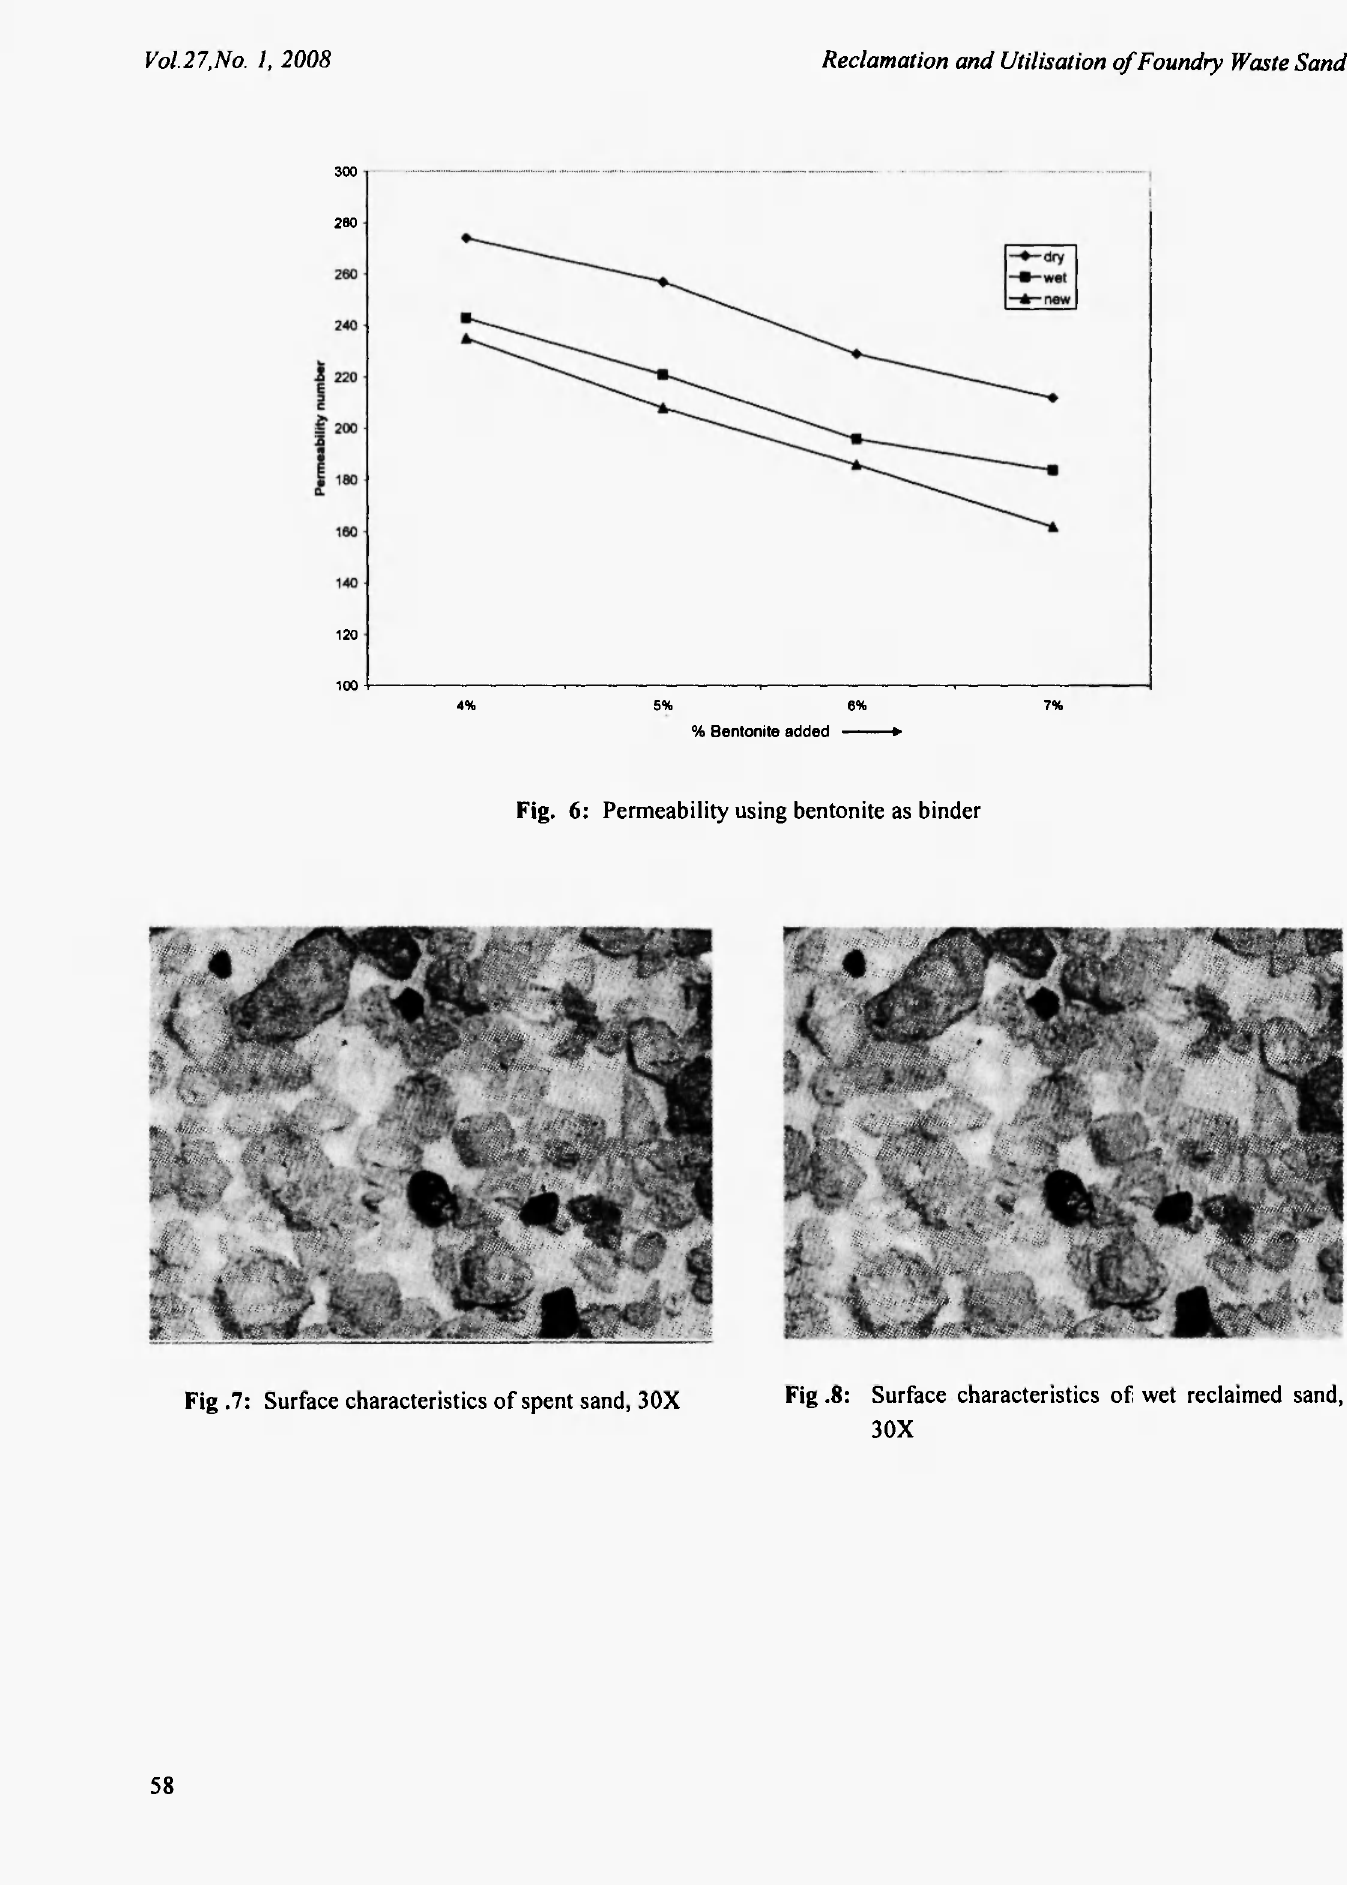
Fig .7: Surface characteristics of spent sand, 30X Fig -8: Surface characteristics of wet reclaimed